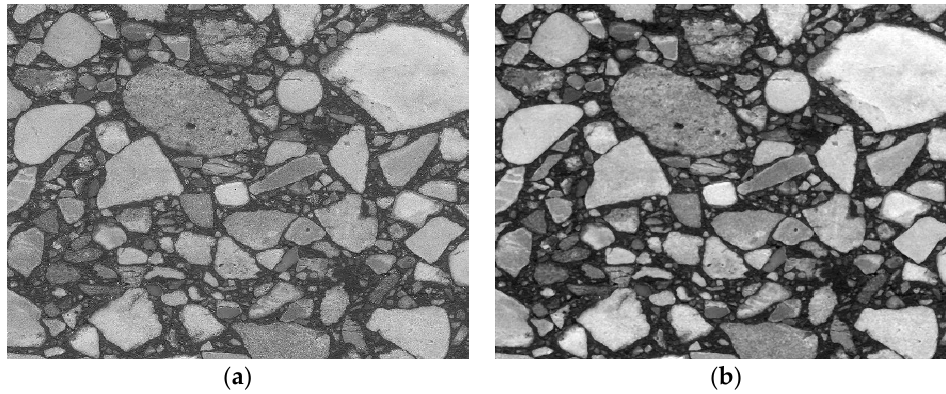
Figure 4. Applying equalization ( b ) on a gray-scale image ( a ).